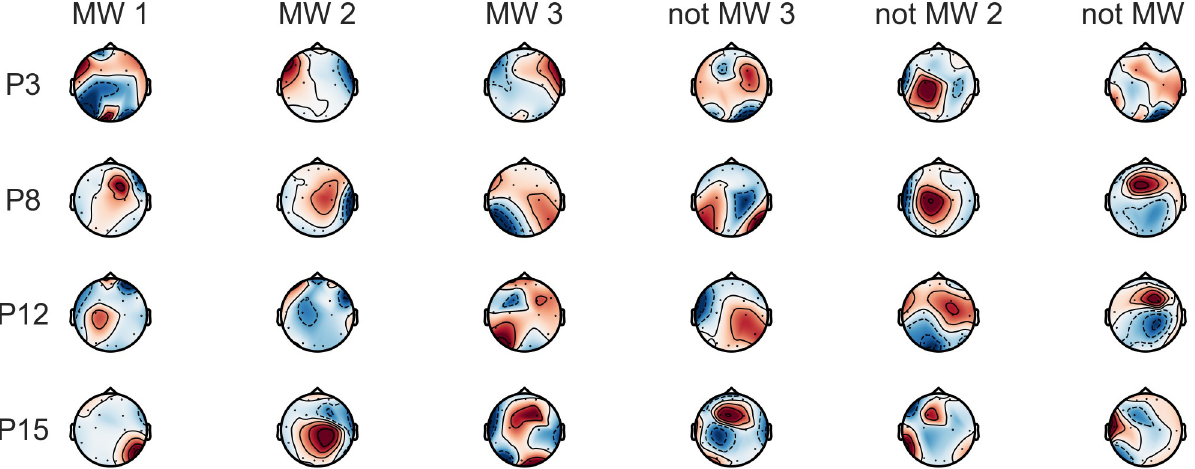
Fig 7. The learned common spatial pattern for four selected participants within frequency band yielding optimal detection (due to space restrictions) after artifact rejection. Note that these patterns do not reflect brain activations; rather, they show where the greatest change in activation took place between MW versus not MW. Pattern one refers to the learned pattern that is most strongly indicative of MW or not MW (listed as MW 1 or not MW 1), and increasing pattern number refers to less predictive patterns.